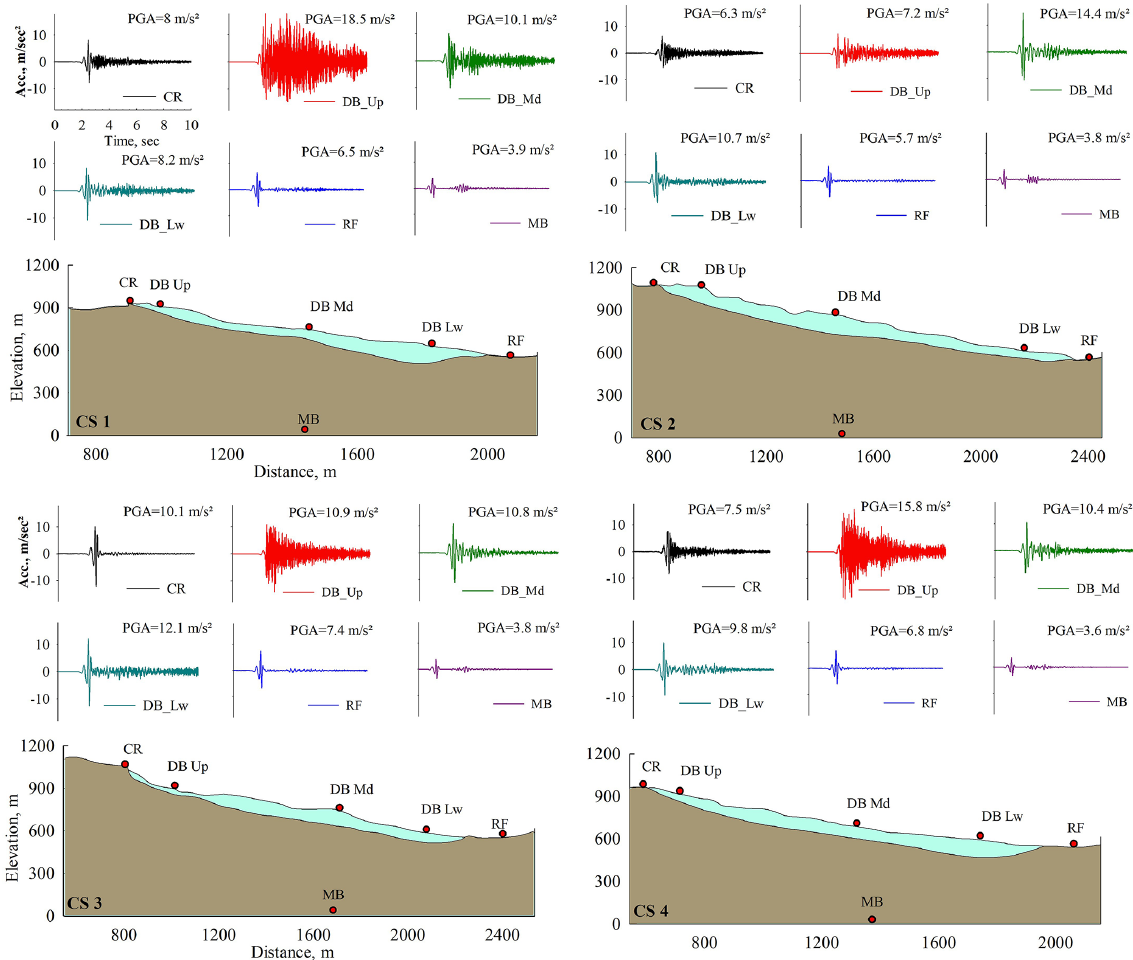
Figure 11. Maximum acceleration at different monitoring